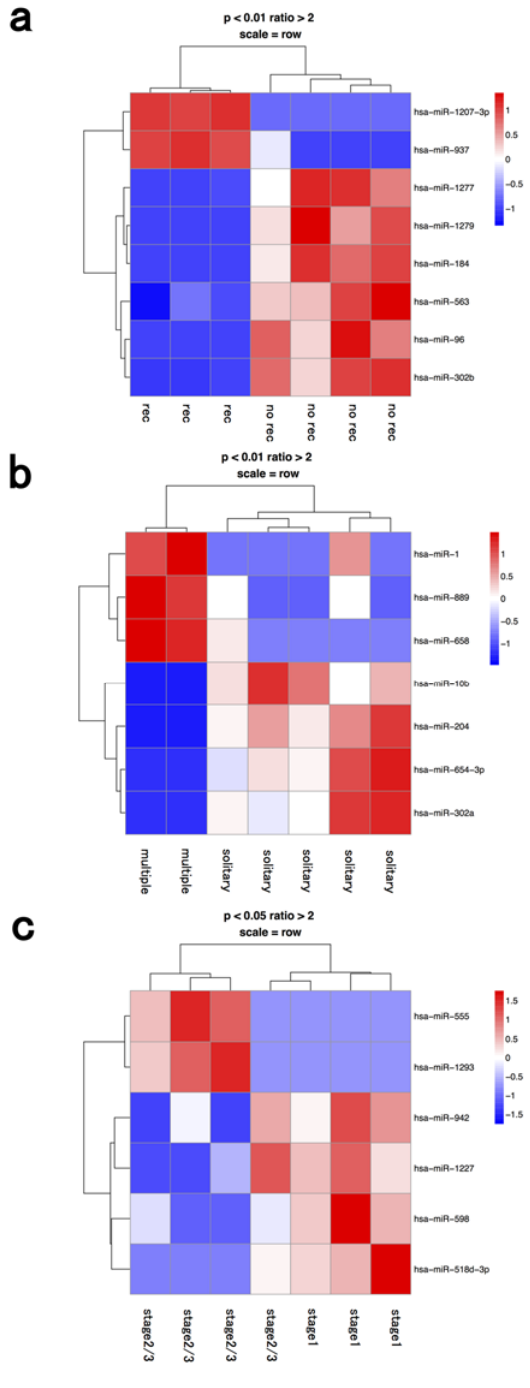
Figure 3. Hierarchical clustering analysis of microRNAs of macrophage fraction in seven patients with hepatocellular carcinoma. Heat map of the miRNA profile in lymphocytes from hepatocellular carcinoma patients with ( a ) recurrence ( n = 3) and no recurrence ( n = 4); ( b ) solitary ( n = 5) and multiple tumors ( n = 2); ( c ) stage 1 ( n = 3) and ≥ stage 2 ( n = 4). Cluster analysis showed eight, seven, and six miRNAs that were significantly differentially expressed between the two groups with a >2-fold change, respectively. Colors range from blue to red, corresponding to low to high expression, respectively. p values <0.01 or <0.05, unpaired t test. rec: